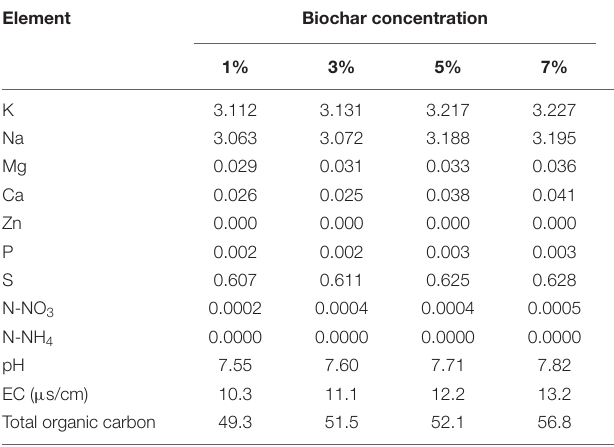
TABLE 1 | Physicochemical properties of biochar-exacted liquor.